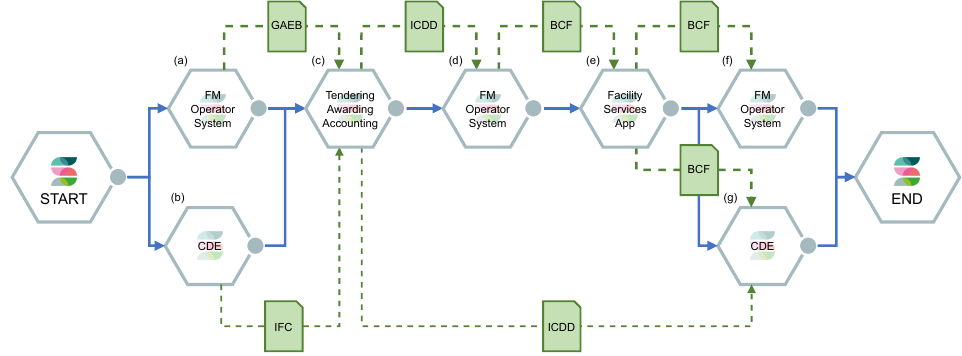
Figure 9. Schematic representation of the use case maintenance task of a building operation